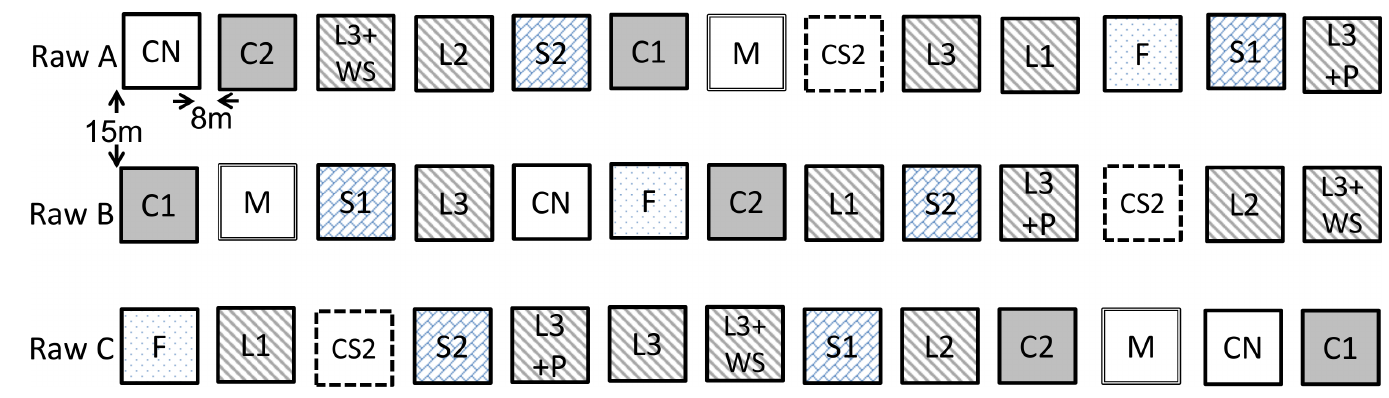
Fig 2. Experimental design. Abbreviations are explained in Table